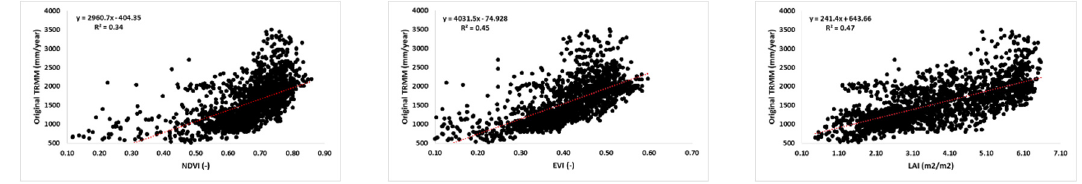
Figure A2. Mean annual values of NDVI, EVI, and LAI versus the original TRMM for the year 2018.